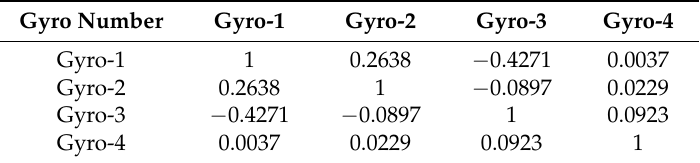
Table 4. Cross-correlation matrix of RRW noise for four-gyro array (Test